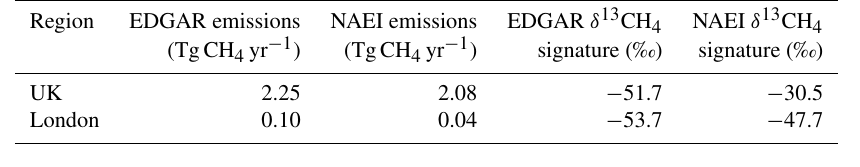
Table 4. EDGAR and NAEI emissions for the UK and London. δ 13 CH 4 is the weighted average of different emission sectors using isotopic source signatures in Table 3.